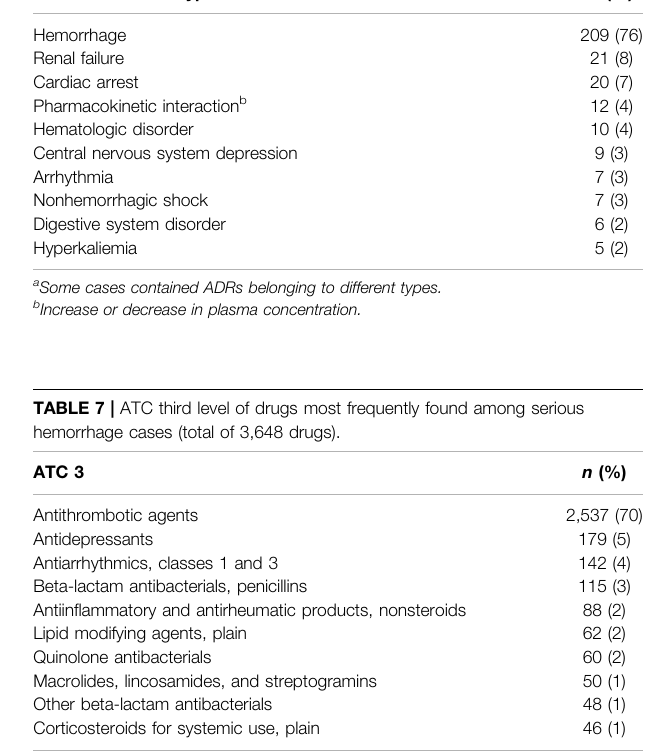
TABLE 4 | Drugs most frequently found among severe cases, ATC fi fth and third level n (cid:1) 8,484. Drugs ATC fi fth level Fluindione